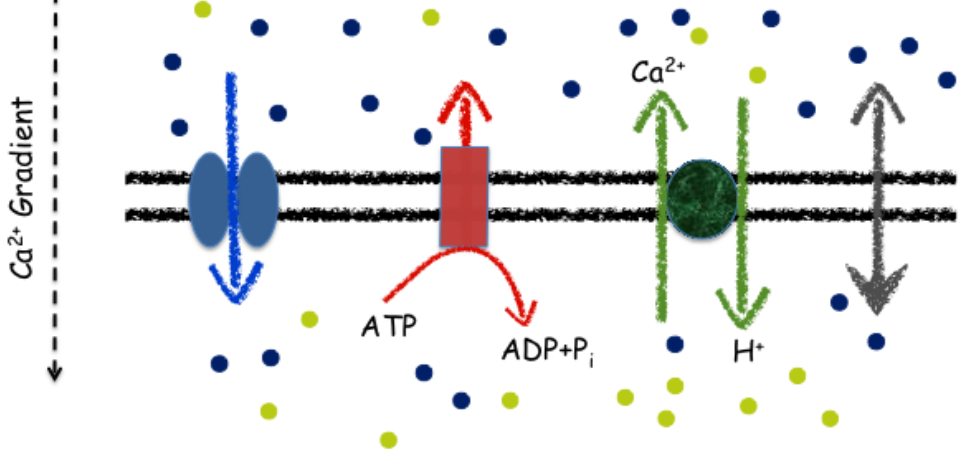
Figure 2. Schematic diagram of different mechanisms of passive and active transport. Ca 2+ (blue dots) is transported across the membrane down its electrochemical gradient by the gated ion channel (blue arrow, left) and by the leak channel (grey arrow, right, with fuller arrowhead pointing to the side with a lower Ca 2+ concentration ) Both the ATP-dependent pump (red arrow) and the Ca 2+ -H + antiporter (green arrows) transport Ca 2+ against its electrochemical gradient, which requires energy. The ATP-dependent pump uses the energy derived from ATP hydrolysis to ADP and inorganic phosphate (P calcium exchanger uses the free energy released from the movement of H + (green